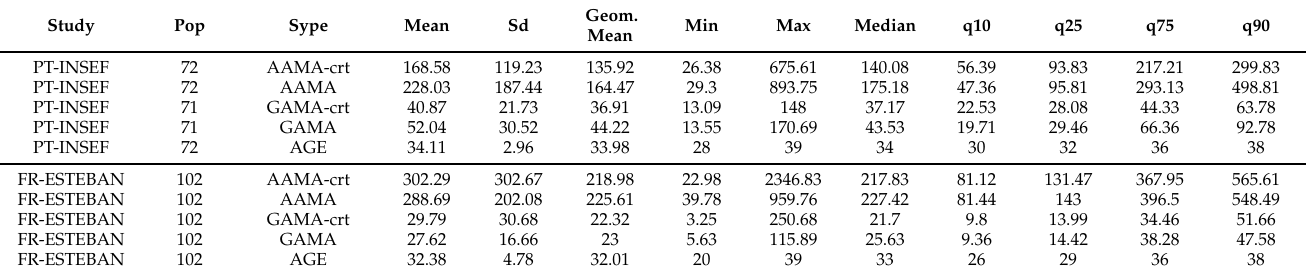
Table A5. Descriptive statistics of acrylamide biomarker levels per study (smoker).